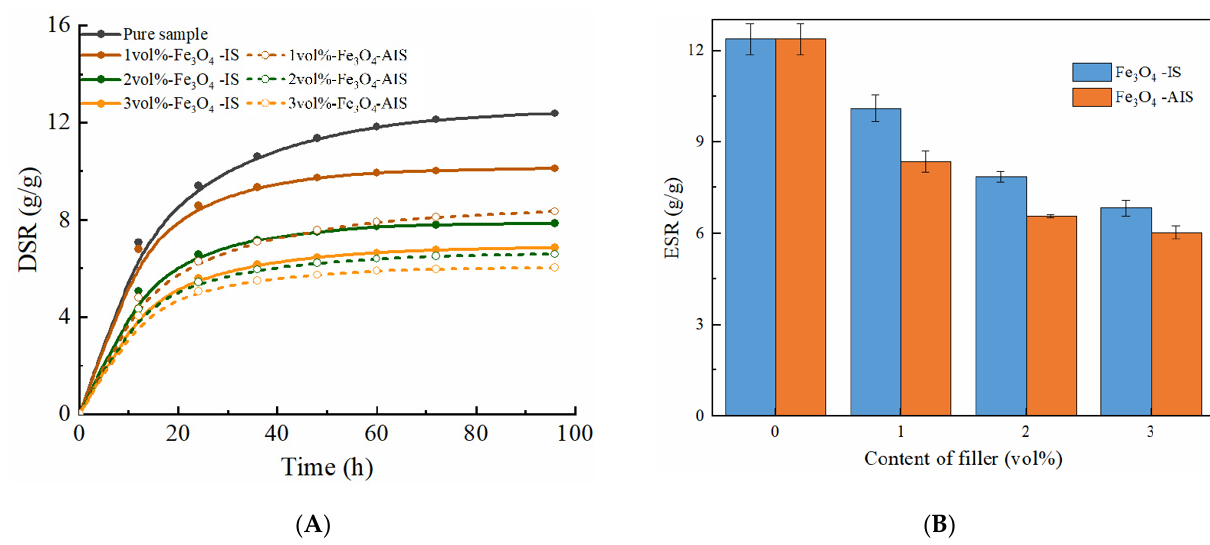
Figure 9. ( A ) The DSR plotted as a function of the swelling time for dried samples with different Fe 3 O 4 content in deionized water. ( B ) The effects of Fe 3 O 4 content on ESR. IS: isotropic samples, AIS: anisotropic samples.